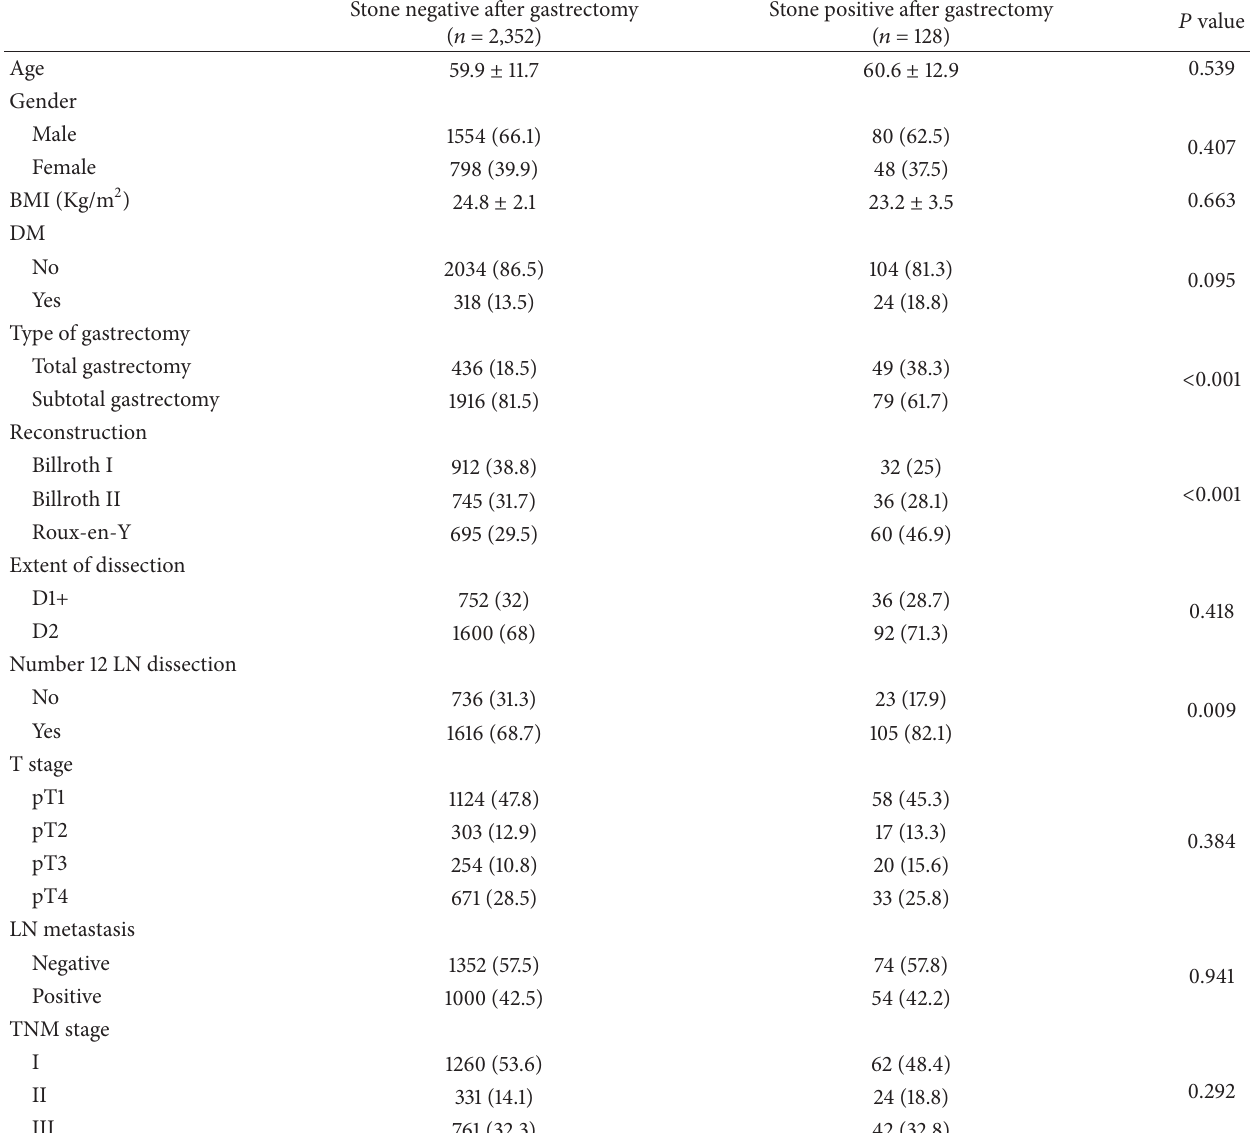
Table 1: Characteristics of the 2480